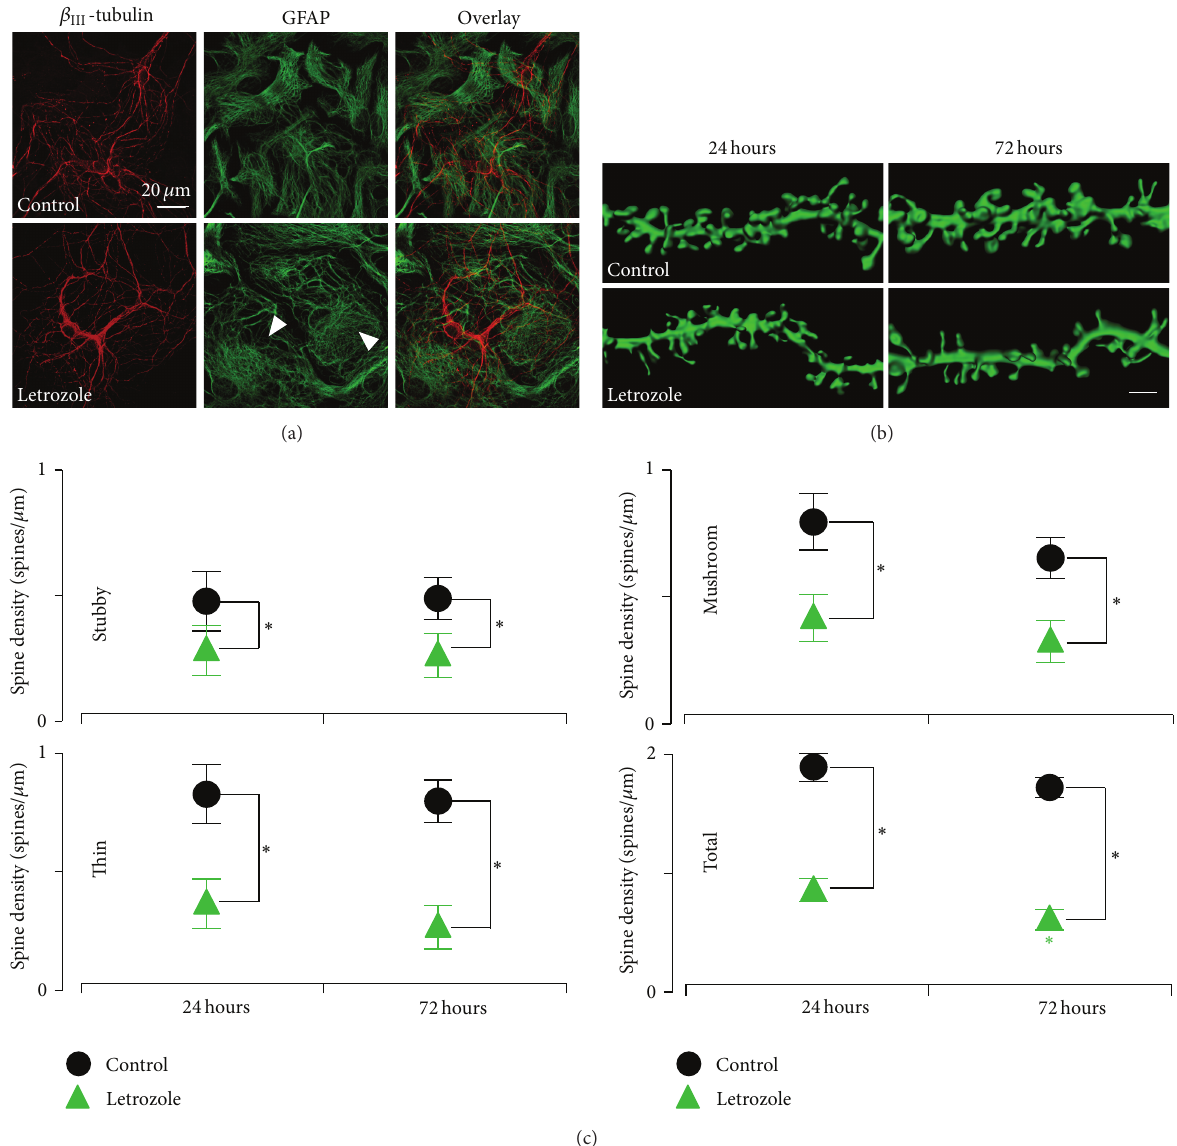
Figure 2: Hypertrophy of astroglia and a loss of dendritic spines following 3-day letrozole treatment. (a) Gender mixed hippocampal neural cells were isolated from 3-day old C57/BL6 mouse pups and fixed in 10% Formalin on DIV7. Shown is confocal images of immunocytochemically labelled hippocampal cell cultures with GFAP (astroglia, green) and 𝛽 -III tubulin (neurons, red). Arrowheads outline astrocytic hypertrophy in letrozole-treated cultures after 72 hours. Scale bar, 20 𝜇 m. (b) Representative 3D reconstructions of dendritic segments from organotypic hippocampal sister slice cultures that were treated with either control or letrozole (1 𝜇 m)-containing media for either 24 or 72 hours. Scale bar, 2 𝜇 m. (c) Quantification of the spine subtype densities following treatments. There is a significant decrease in the densities for all spine subtypes following letrozole treatment compared to control. 24-hour treatment, control, n = total dendritic segment lengths of 441 𝜇 m from 10 cells in 4 cultures; letrozole, 𝑛 = 433 𝜇 m of dendrite from 9 cells in 4 cultures. 72-hour treatment, control, 𝑛 = 500 𝜇 m of dendrite from 12 cells in 4 cultures; letrozole, 𝑛 = 489 𝜇 m of dendrite from 11 cells in 4